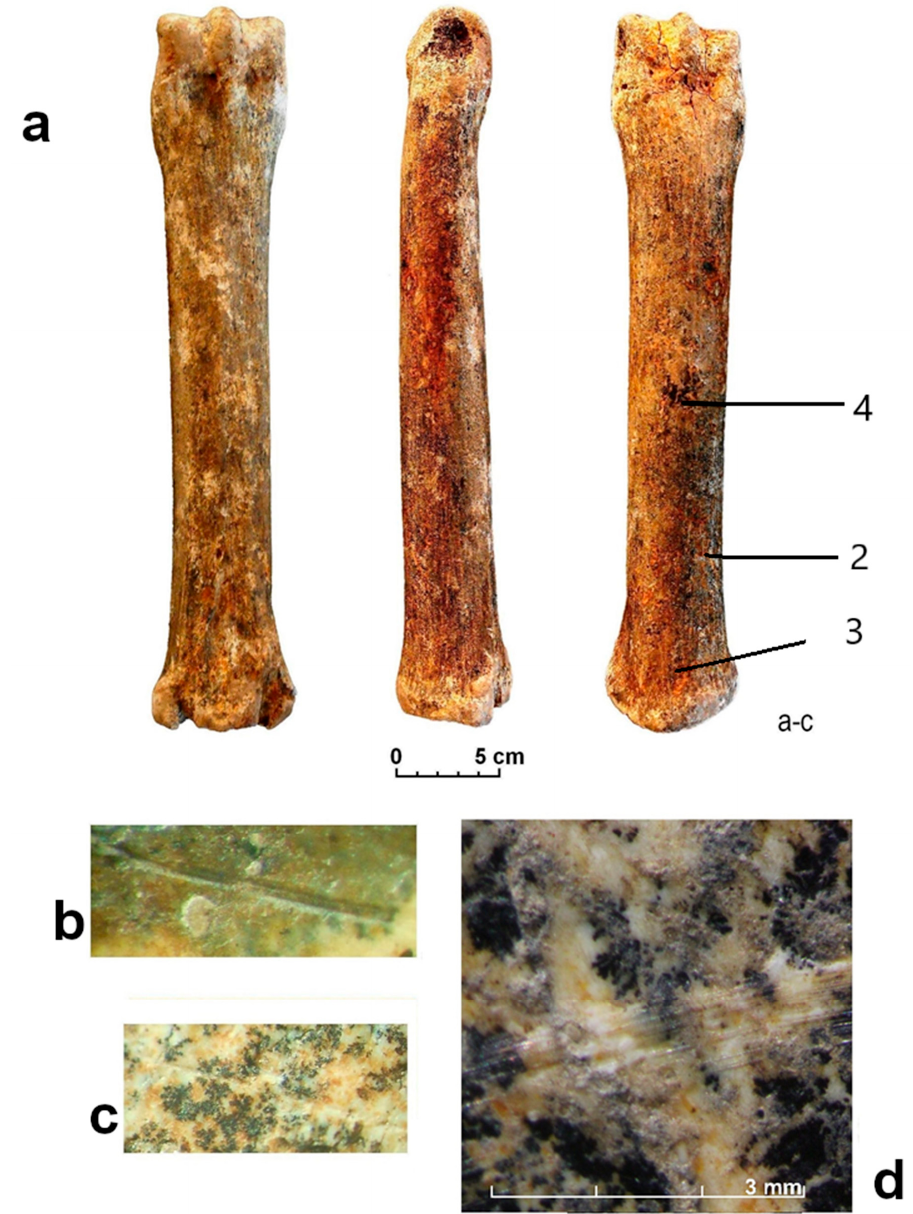
Figure 21. Mosbach. ( a ) Silicified metatarsus from a horse with cut marks ( b – d ). (Photos: C. Humburg.).